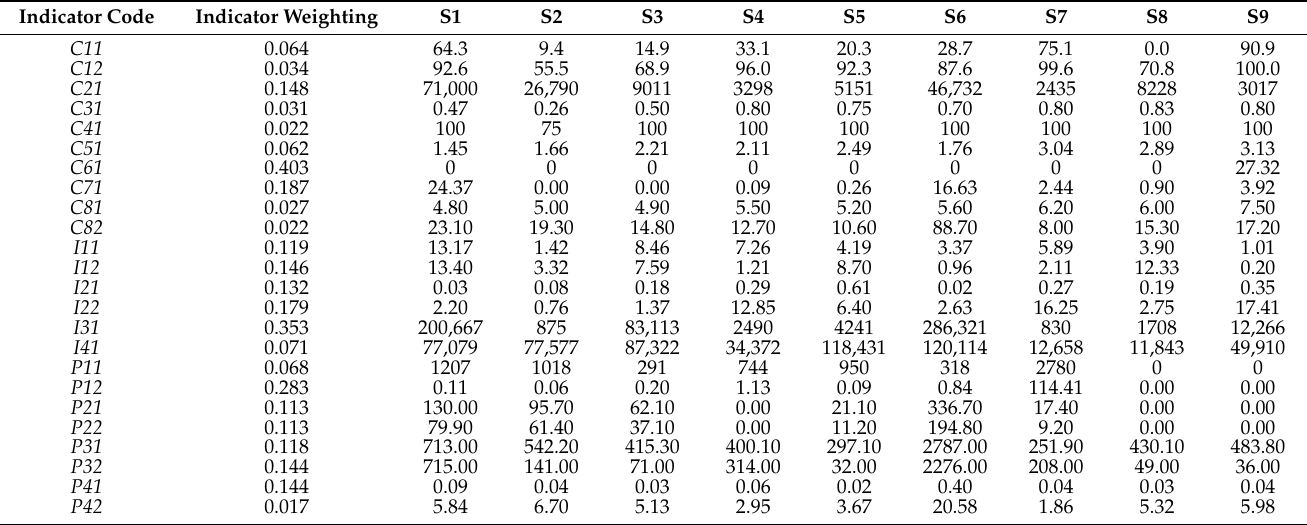
Table 5. Calculation results of the evaluation indicators of subregions (raw